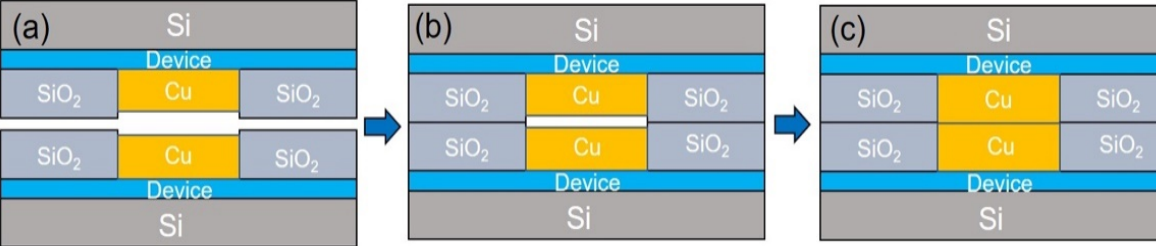
Figure 8. Schematic of the ideal bonding mechanism of the Cu/SiO 2 hybrid system. ( a ) Sides with Cu bumps in SiO 2 via. The height of the Cu bump is slightly lower than the surrounding SiO 2 layer. ( b ) Alignment and bonding of SiO 2 to SiO 2 at room temperature. ( c ) Heating to close the dishing gap and induce pressure in the Cu bump. The pressure was created due to the large CTE of the Cu. No external pressure is needed at the third stage.